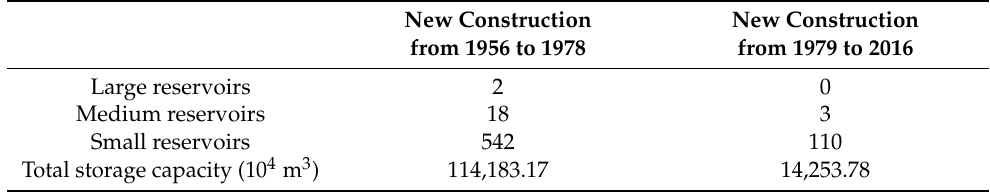
Table 7. Comparison of the number of new reservoirs before and after the